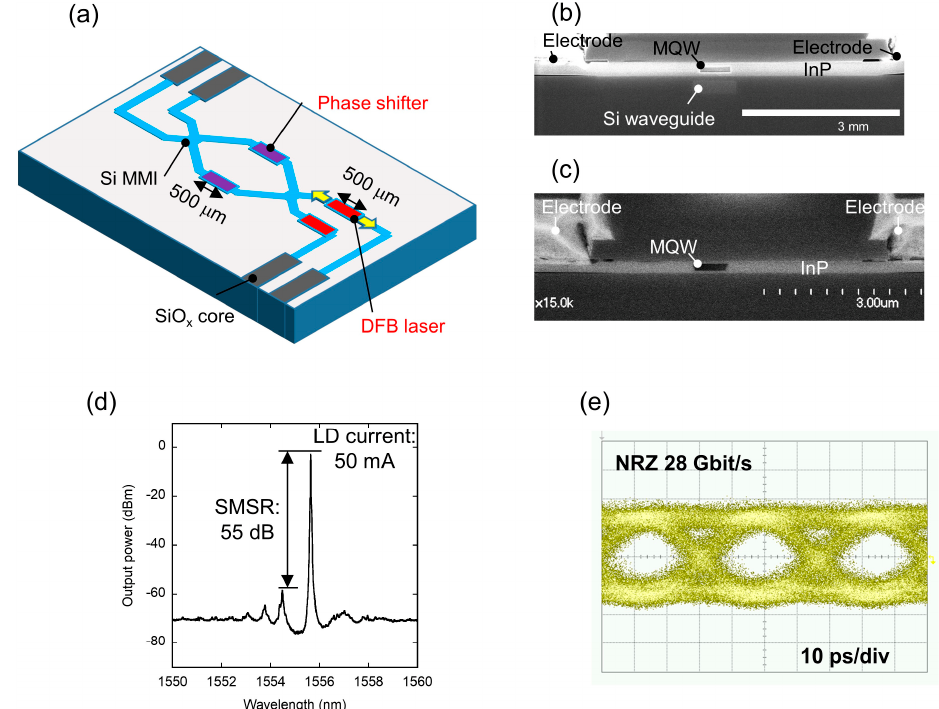
Figure 16. ( a ) Bird’s eye view of an laser diode (LD) ‐ Mach ‐ Zehnder modulators (MZM) integrated chip; ( b , c ) cross ‐ sectional SEM images of distributed feedback (DFB) LD and phase shifter; ( d ) SEM images of distributed feedback (DFB) LD and phase shifter; ( d ) lasing spectrum of output light from MZM output port; lasing spectrum of output light from MZM output port; ( e ) eye diagram with 28 Gbit/s NRZ sig ‐ ( e ) eye diagram with 28 Gbit/s NRZ nal.